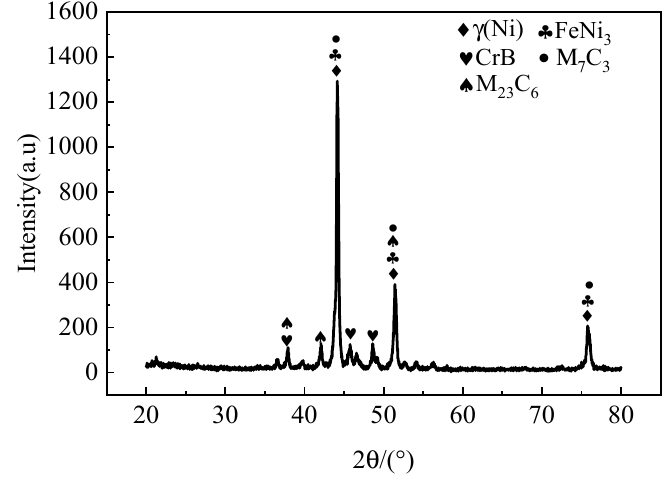
Figure 14. XRD pattern of Ni60PTA laser cladding layer.